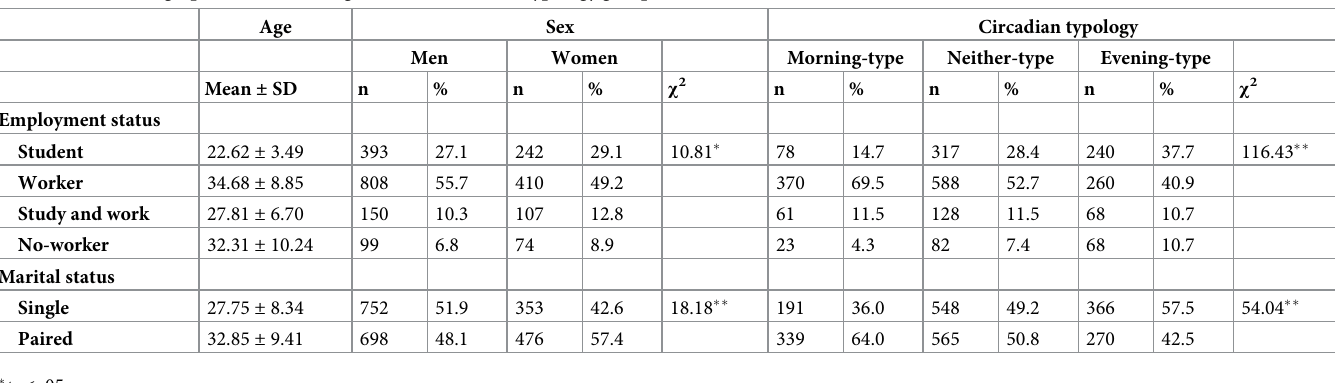
Table 1. Sociodemographic data according to sex and circadian typology groups. Age